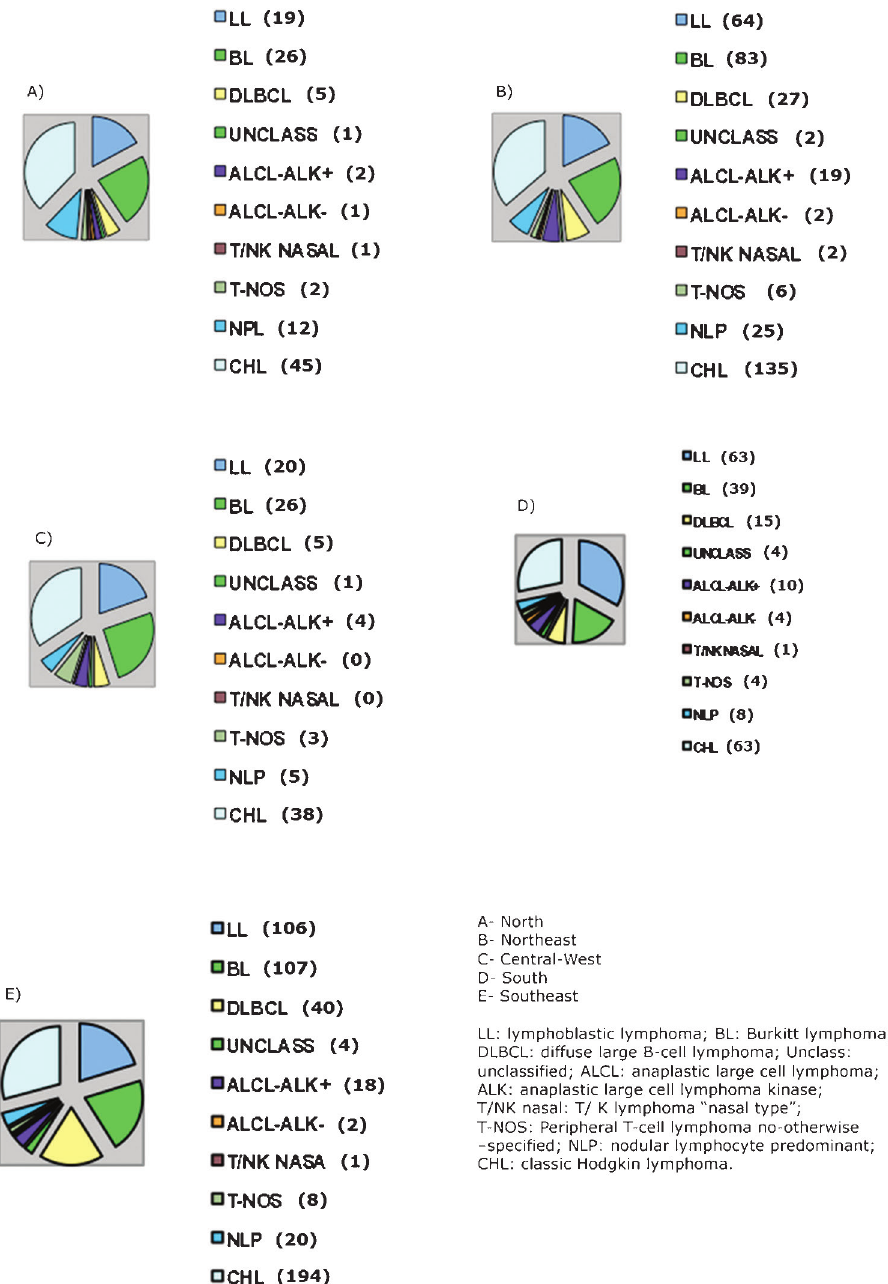
Figure 7 - Distribution of all cases of pediatric lymphomas according to geographic regions. A: North, B: Northeast, C: Central-West, D: SouthE, Southeast. LL: lymphoblastic lymphoma; BL: Burkitt lymphoma; DLBCL: diffuse large B-cell lymphoma; Unclass: unclassified; ALCL: anaplastic large cell lymphoma; ALK: anaplastic large cell lymphoma kinase; T/NK nasal: T/K lymphoma ‘‘nasal type’’; T-NOS: peripheral T-cell lymphoma not otherwise specified; NLP: nodular lymphocyte predominant; CHL: classic